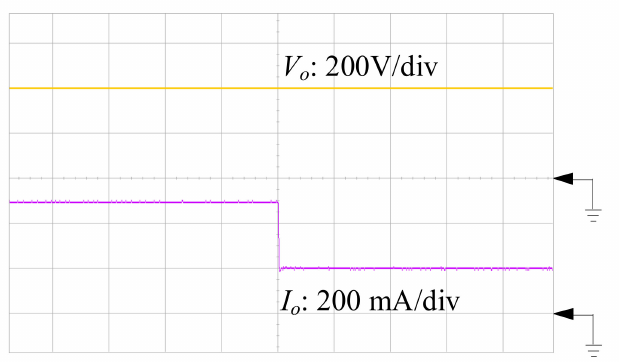
Figure 9. Measured output voltage and current waveforms to illustrate transient response under step change.